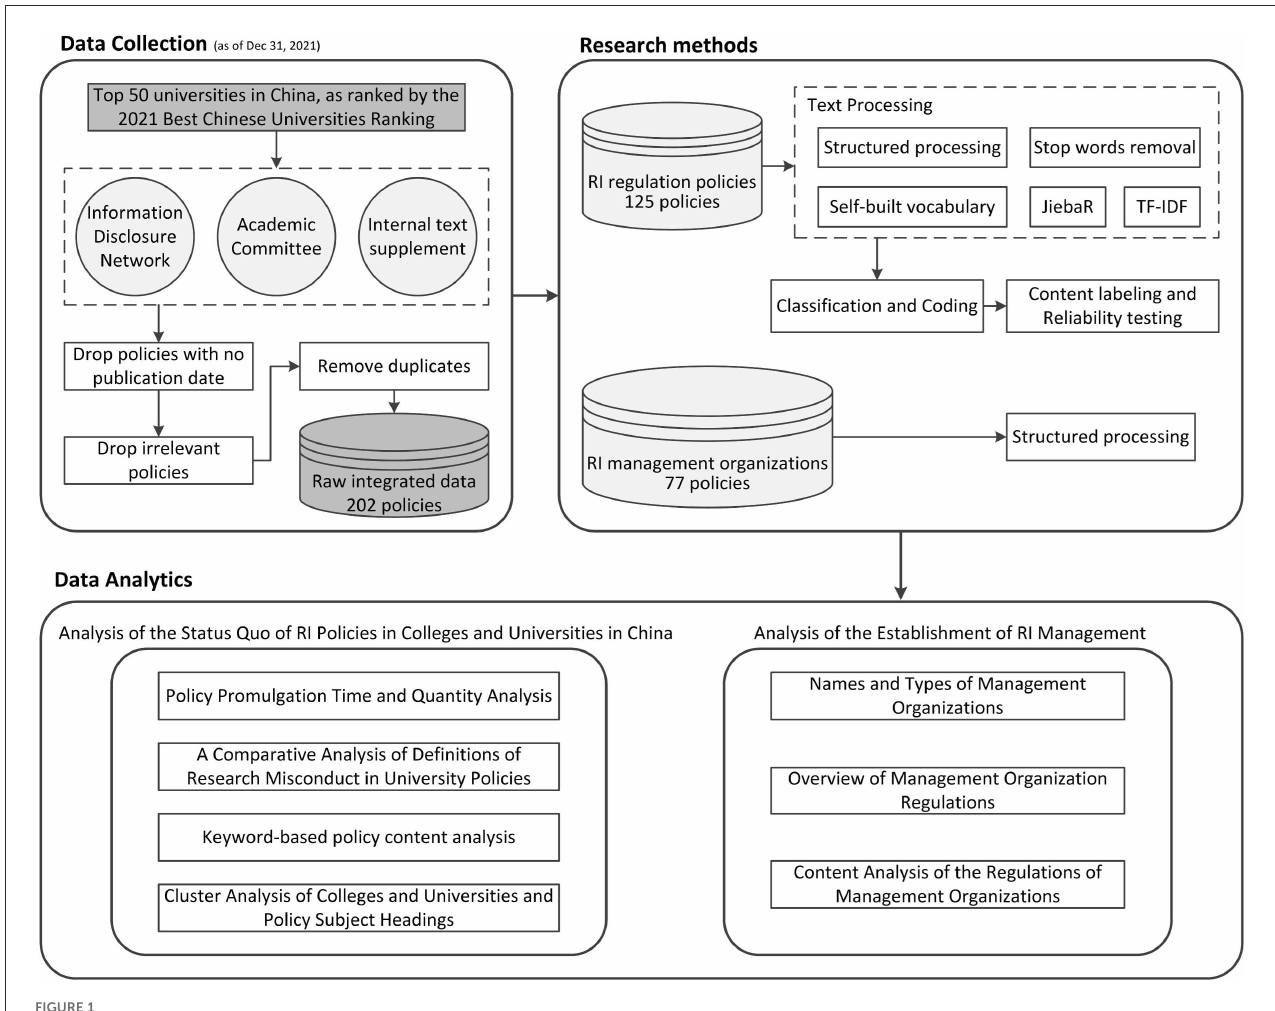
FIGURE1 The flowchart illustrating the data processing in this